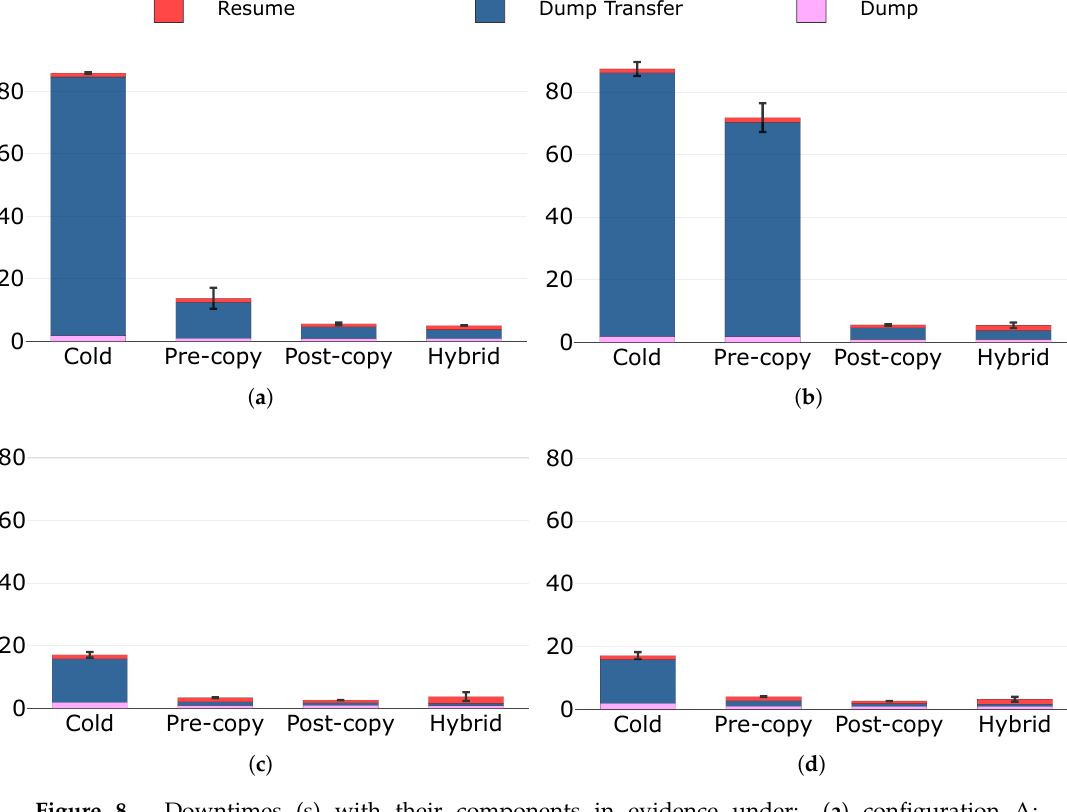
Figure 8. Downtimes (s) with their components in evidence under: ( a ) configuration A; ( b ) configuration B; ( c ) configuration C; and ( d ) configuration